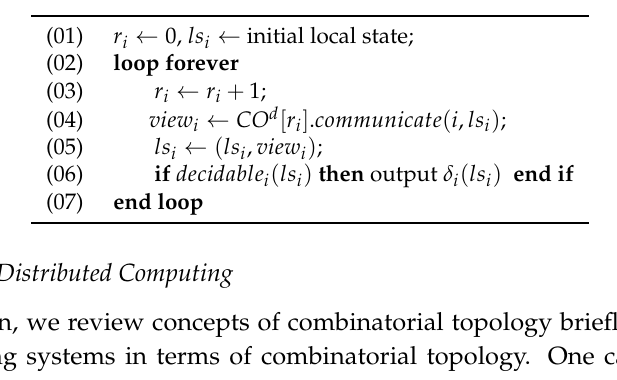
Table 1. Process p i for a full-information